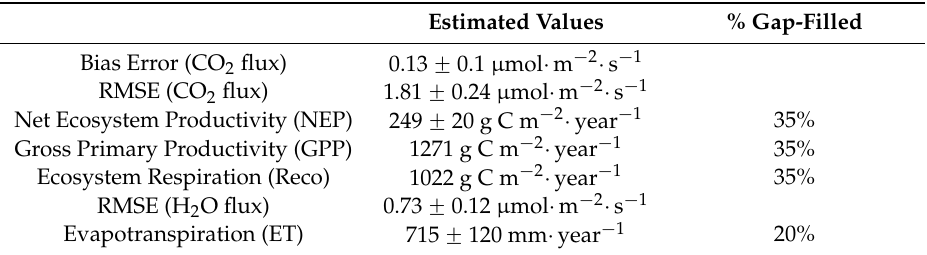
Table 1. Summary table of annual estimates of CO 2 fluxes and evapotranspiration rates (ET) over the study period.